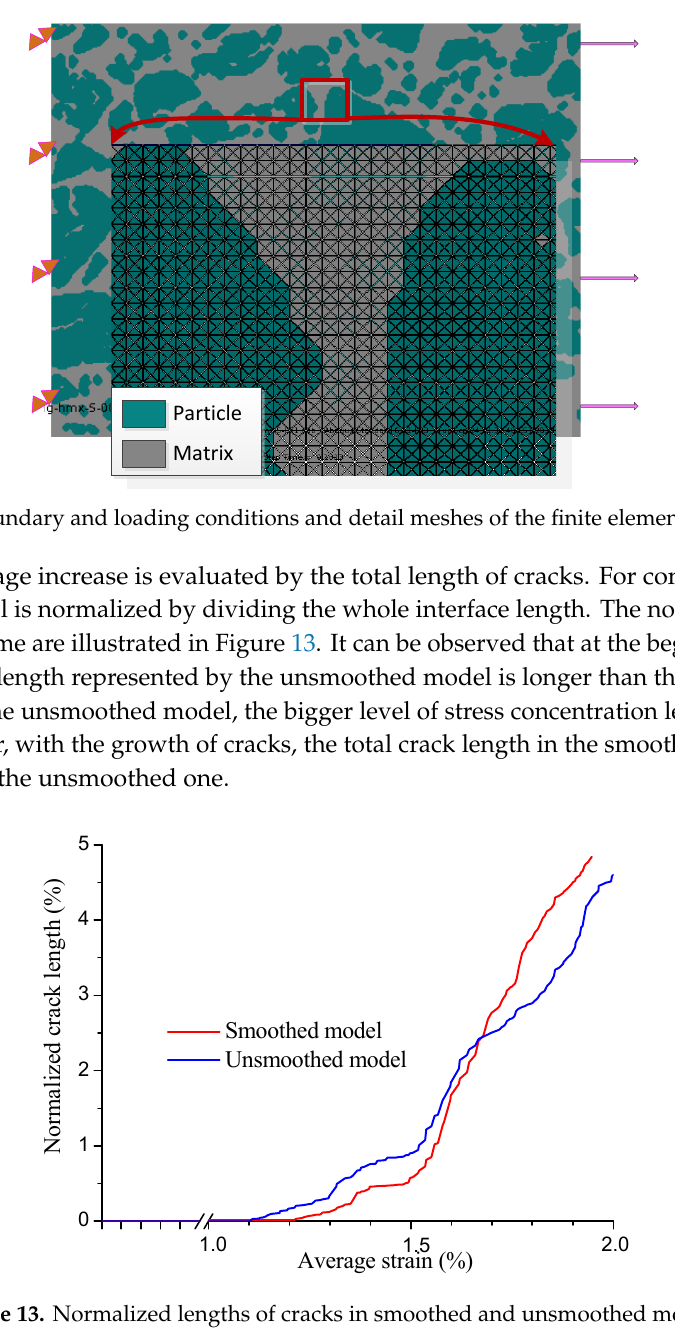
Figure 13. Normalized lengths of cracks in smoothed and unsmoothed model.